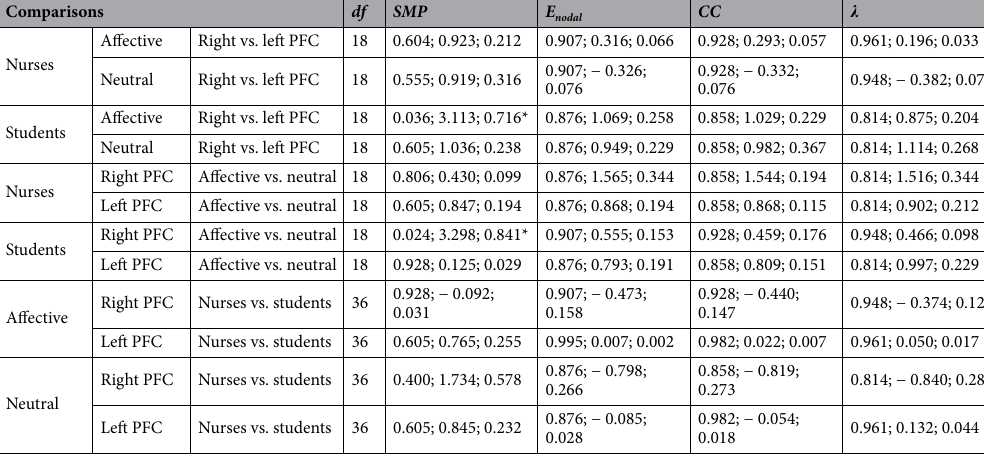
Table 2. Pairwise comparison of FC indices in regional semi-metric analysis and graph theory analysis. The values in table are displayed in (FDR-adjusted p -values; t -values; Cohen’s d ). df represents degrees of freedom. * indicates FDR-adjusted p < 0.05.